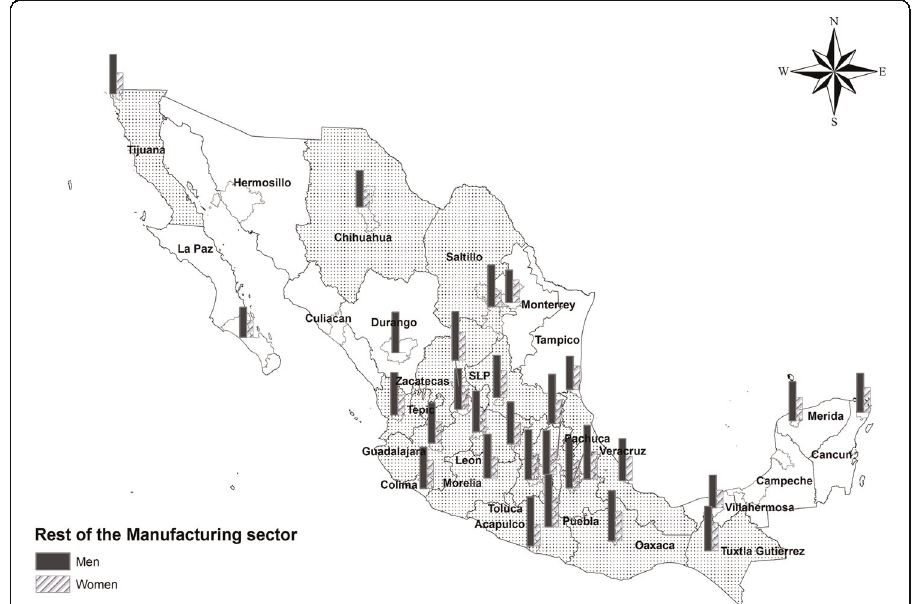
Fig. 2 Precariousness: the rest of the manufacturing sector, 2018. Source: Author ’ s extrapolation with data from the